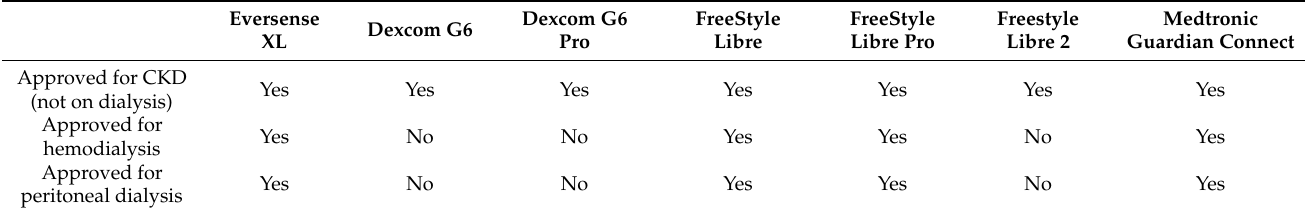
Table 1. Overview of CGM